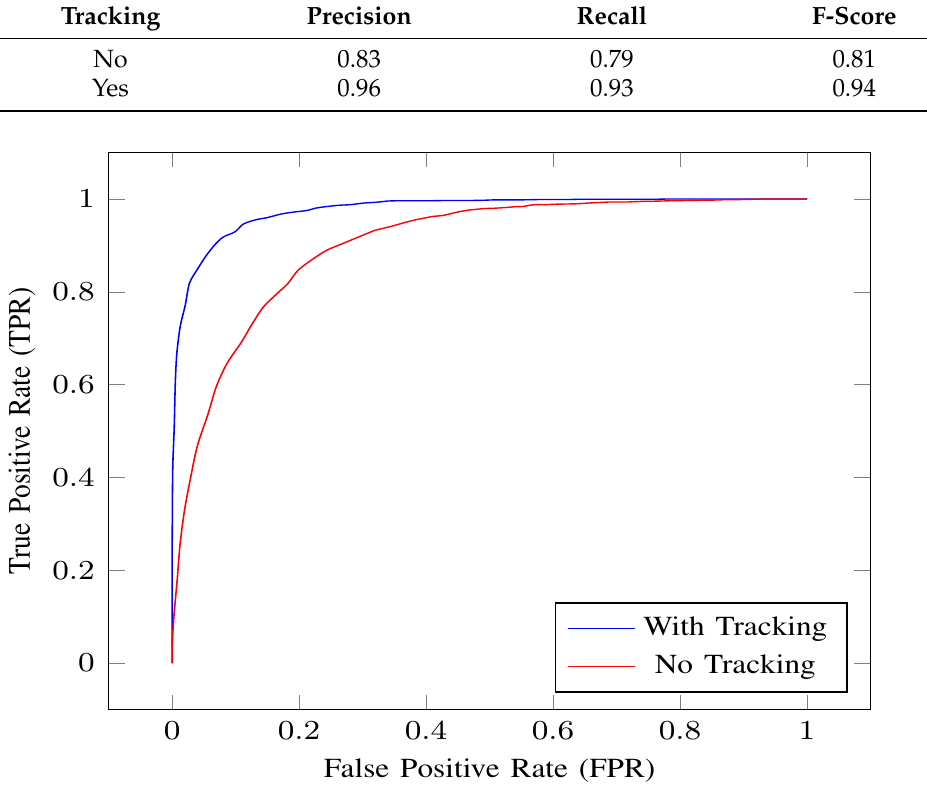
Figure 5. ROC Curve of ChokePoint Dataset for the Proposed